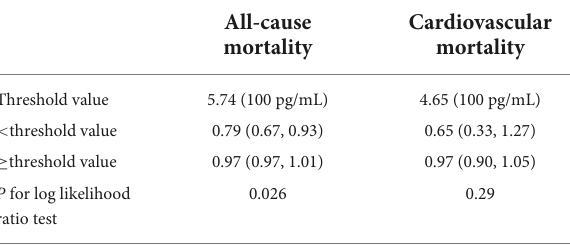
TABLE 3 The result of two-piecewise linear regression model between serum Klotho concentrations and all-cause mortality and cardiovascular mortality in American adults with